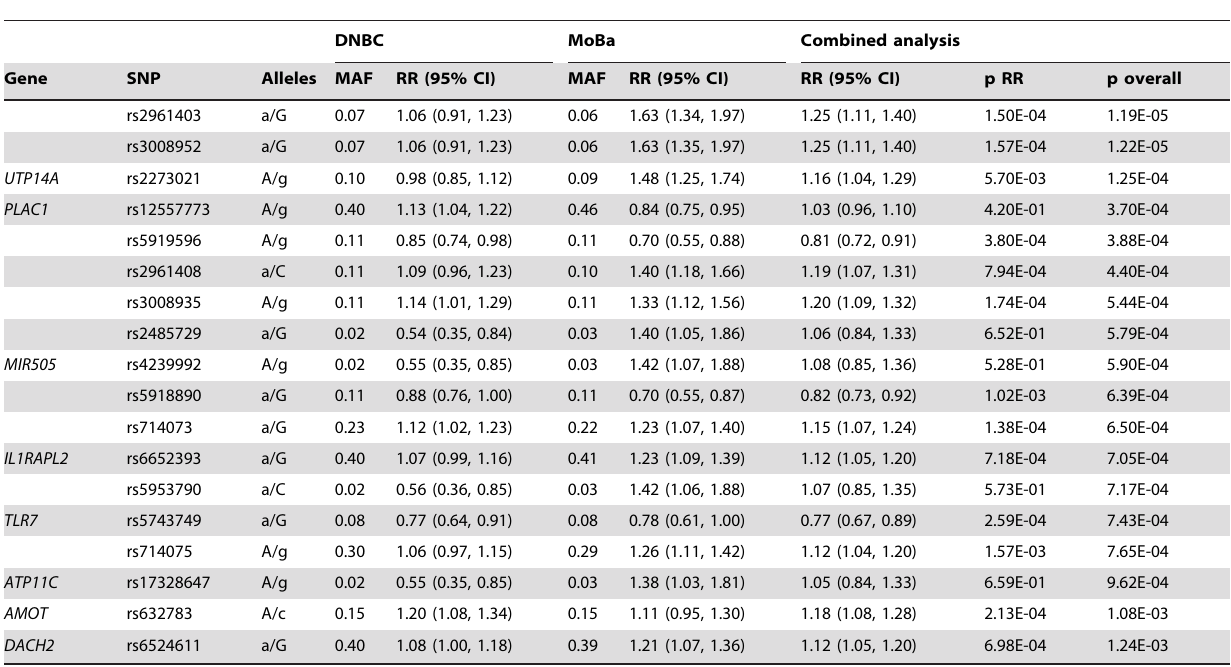
Table 4. Fetal results from the two independent GWAS and the combined analysis.